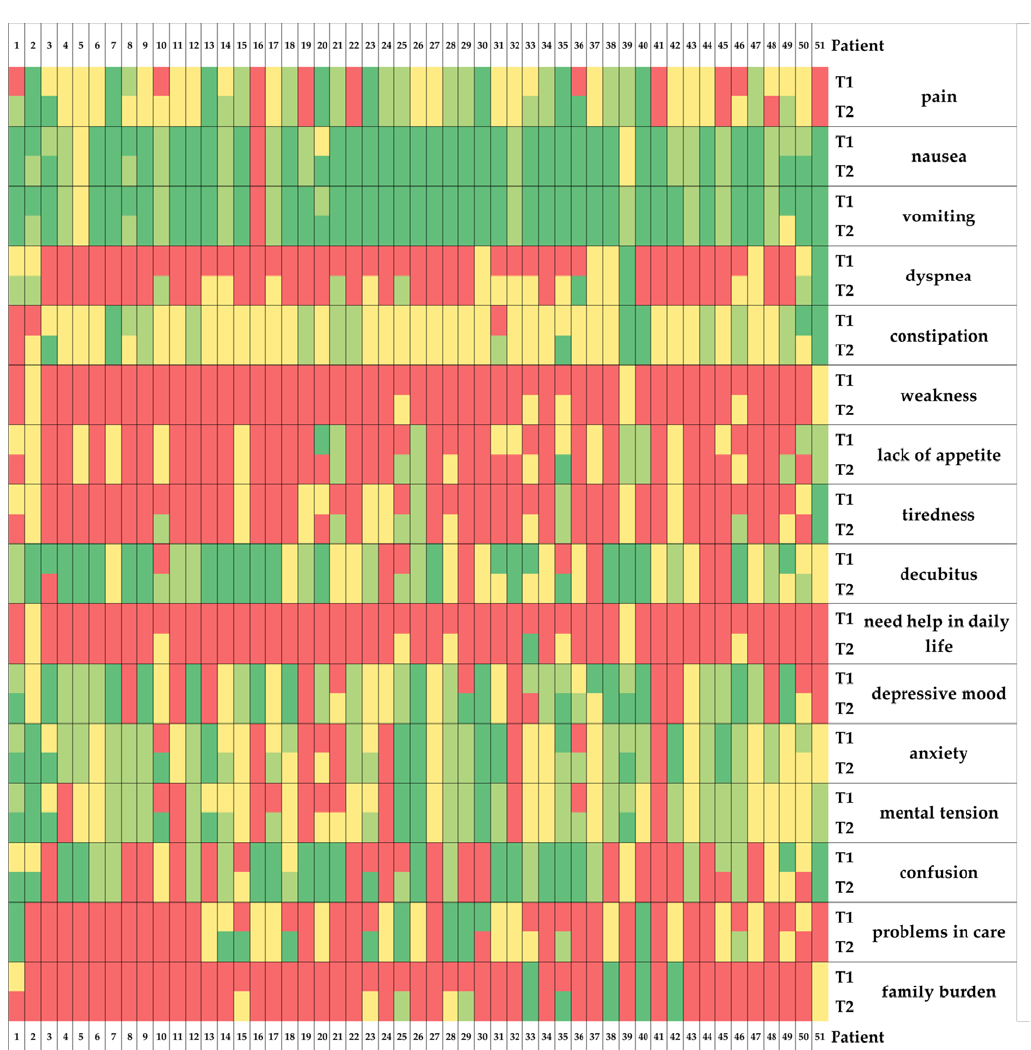
Figure 2. Heatmap indicating symptom intensity at the beginning (T1) and end (T2) of specialist palliative care in COVID-19 patients in the intensive care unit. Color-coding: no symptoms = green, light symptoms = bright green, moderate symptoms = yellow and severe symptoms = red.